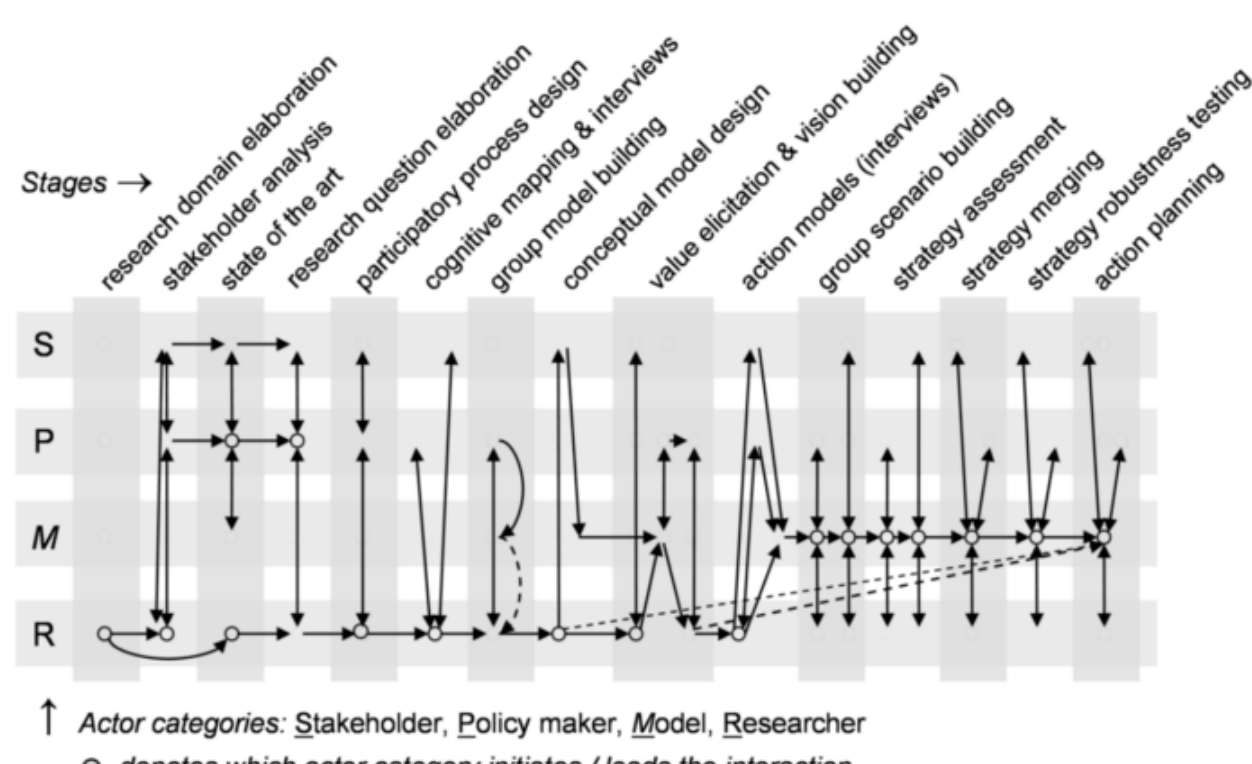
Fig. 5. Flow of interactions with diversity of involvement from each category on the AquaStress Bulgarian case